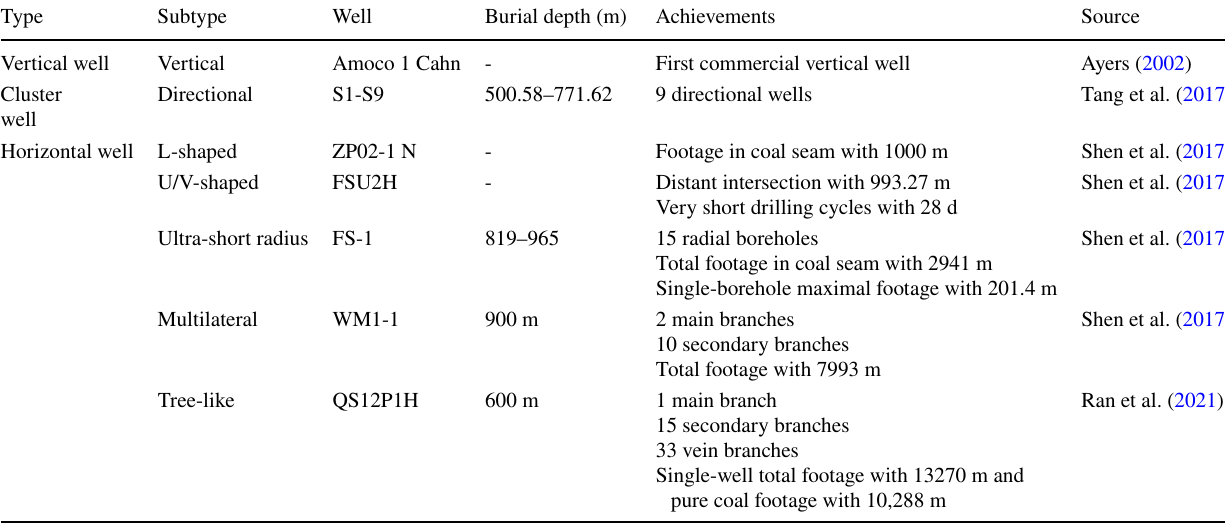
Table 3 Some drilling achievements of several typical CBM well types